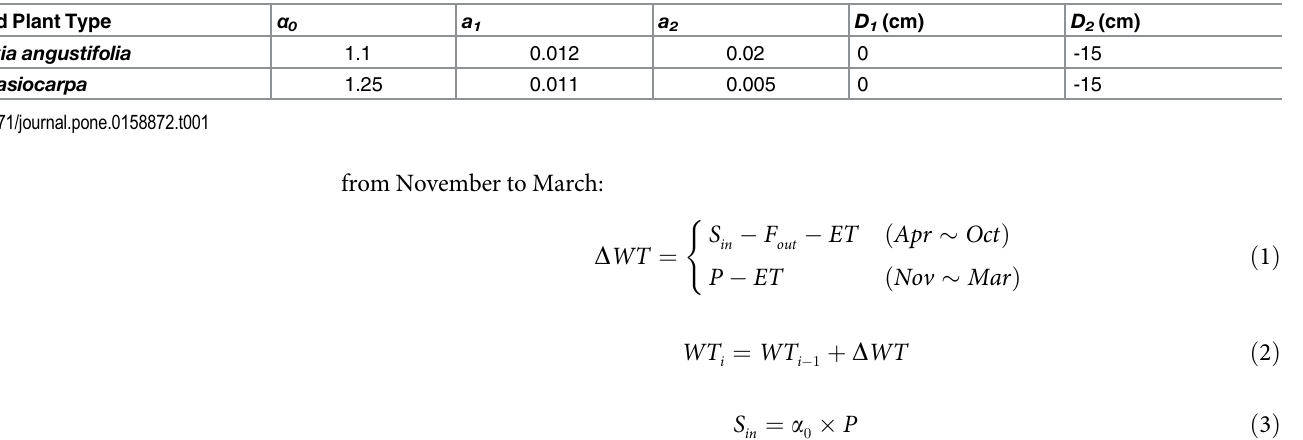
Table 1. Parameter values for the main kinds of wetland in the Sanjiang